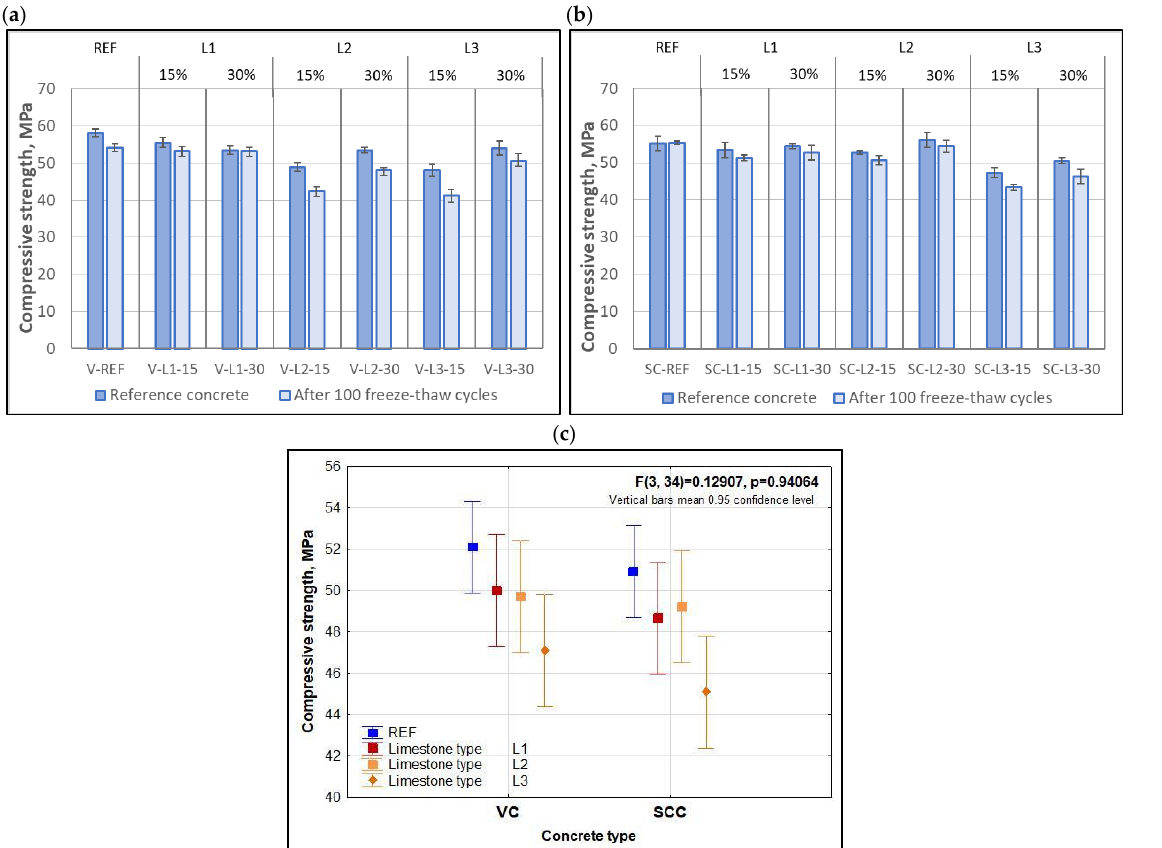
Figure 7. Compressive strength of ( a ) vibrated concrete and ( b ) self-compacting concrete, both without air-entraining admixture, with ( c ) ANOVA analysis of the effect of using limestone.